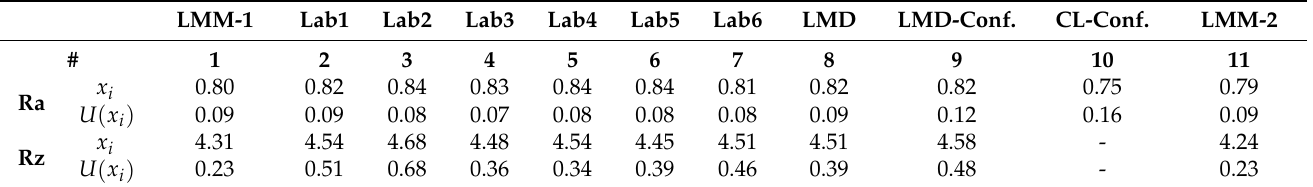
Table 1. Measuring results from each participant laboratory for Ra and Rz roughness